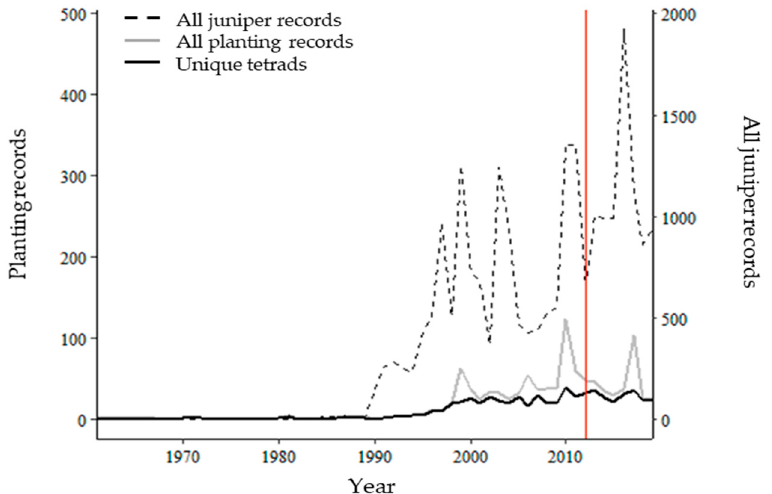
Figure 2. Juniper records 1960 to 2019, comparing all records collected at ≥ 2 km resolution (dotted line) with all planting records (grey line), the number of tetrads (2 km × 2 km grid cells) planted each year (black line) and the first detection of P. austrocedri infecting a juniper population in the wider environment (red line).